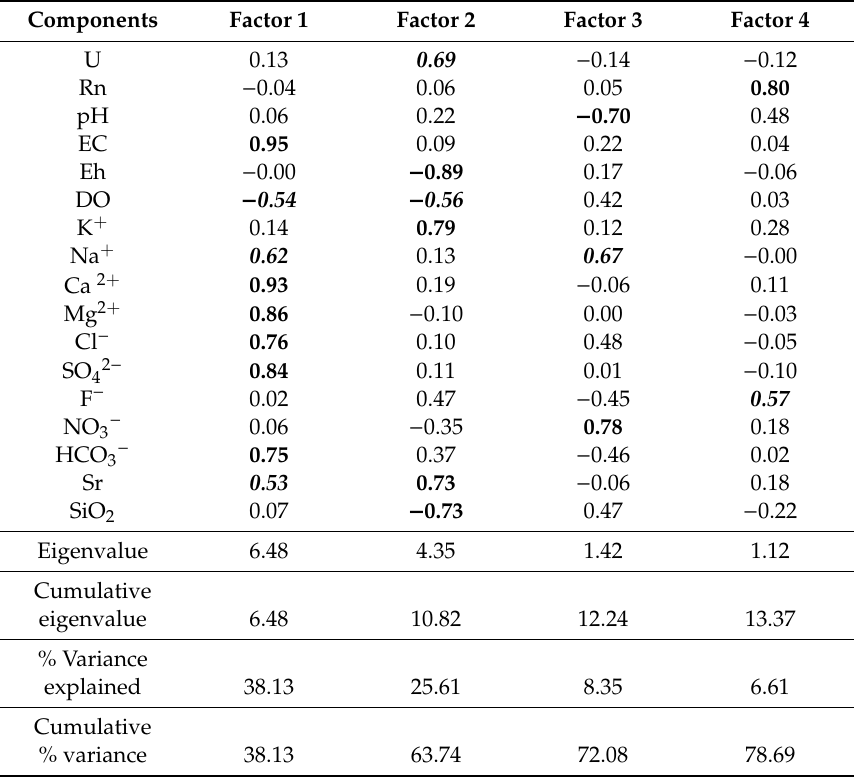
Table 3. Rotated factor loadings for groundwater samples using hydrogeological components. Bold values indicate significant strong factor loadings ( − 0.70 < or > 0.70) and bold italic values indicate moderate to strong factor loadings ( < − 0.50 or > 0.50).